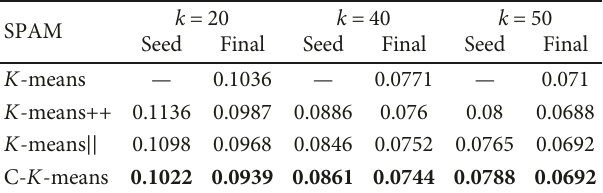
Table 10: Median cost (over 10 runs) on the SPAM dataset.